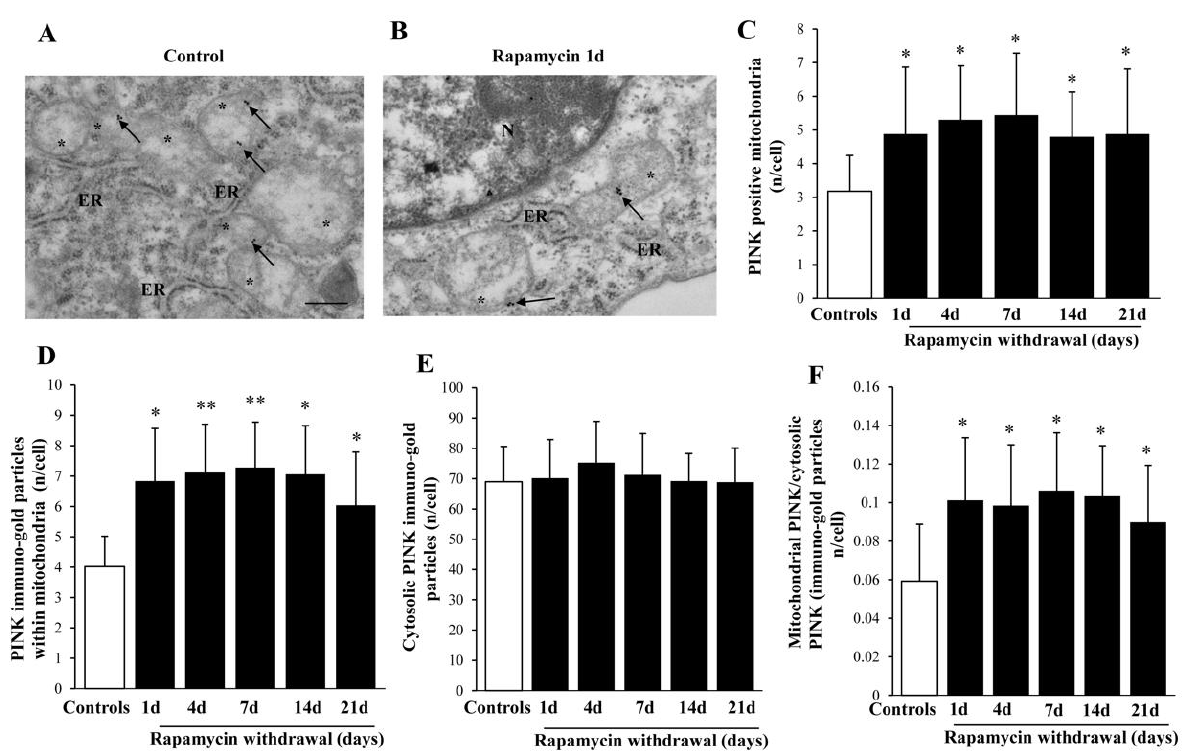
Figure 10. Representative immuno-gold and polarization graphs for PINK1. Representative TEM micrograph showing PINK1-positive mitochondria from control ( A ) and following 1 d rapamycin withdrawal ( B ). Arrows point to PINK1 immuno-gold particles within mitochondria. Graphs report the PINK1-positive mitochondria ( C ), PINK1 immuno-gold particles within mitochondria ( D ), the cytosolic amount of PINK1 ( E ), and the ratio of mitochondrial to cytosolic PINK1 particles ( F ). Values reported in the graph correspond to the mean ± SD. Mitochondria were counted in 50 cells per group. * p ≤ 0.05 compared with controls. ** p ≤ 0.05 compared with controls and 21 d. Scale Bar = 0.5 µ m, Asterisk (*) = mitochondria, ER = endoplasmic reticulum, N = nucleus.